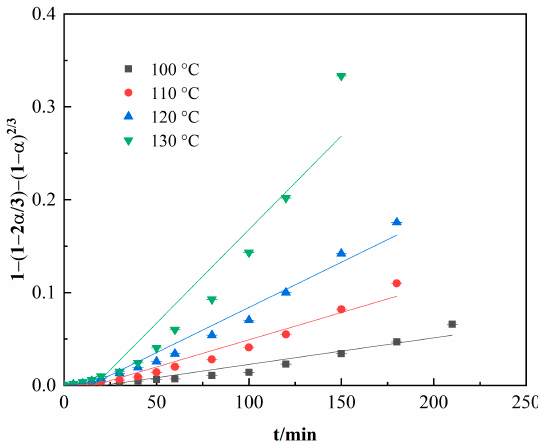
Figure 4. Relationship between 1 − (1 − 2 α /3) − (1 − α ) 2/3 and time at different temperatures.